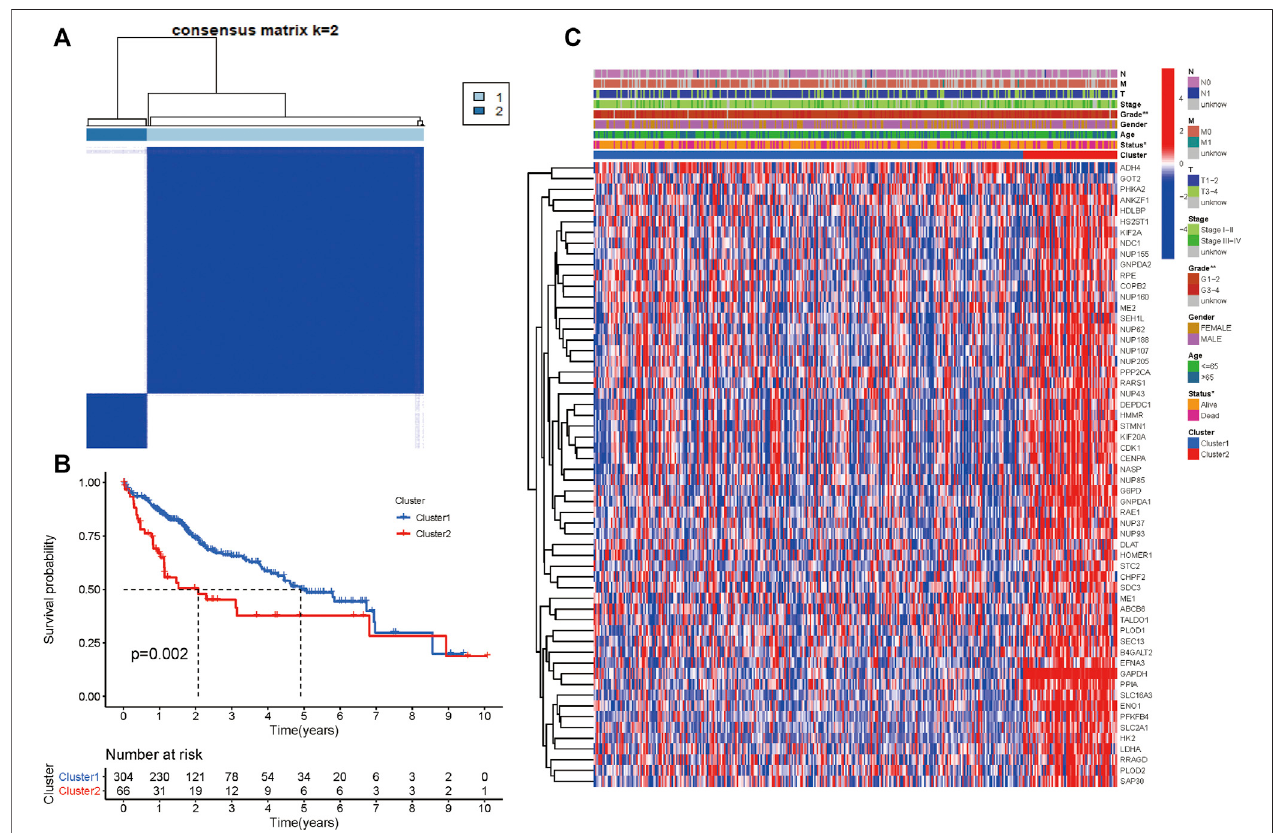
FIGURE3| DifferentialclinicopathologicalcharacteristicsandsurvivalofHCCpatientsintwoclusters. (A) Consensusmatrix(k=2). (B) Heatmapshowingdifferent clinicopathologic features between the two clusters. (C) K-M curves for HCC patients in two clusters.